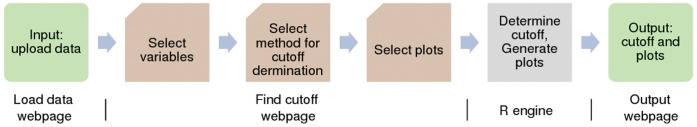
Workflow of Cutoff Finder.The track below the icons refers to the places where the steps of data processing are done. These are the steps of data procession: 1. Data are uploaded from a tab-separated file or imported from one of three example data sets. 2. The user selects the biomarker and optionally outcome and survival variables from the table columns. 3. The user selects the method for cutoff determination. 4. The user chooses the set of plots to be generated. 5. The optimal cutoff point is determined and analysis plots are generated using R as statistical engine. 6. Cutoff point and plots are shown at the results webpage.